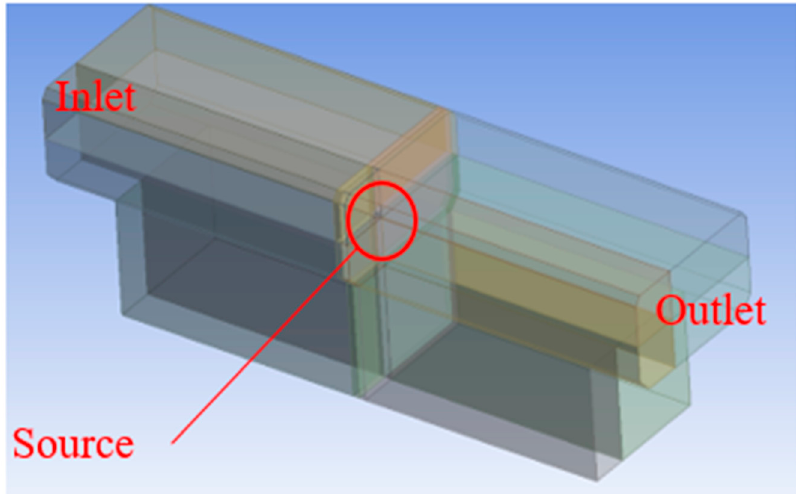
Figure 16. Model of the large cavitation tank at National Taiwan Ocean University.